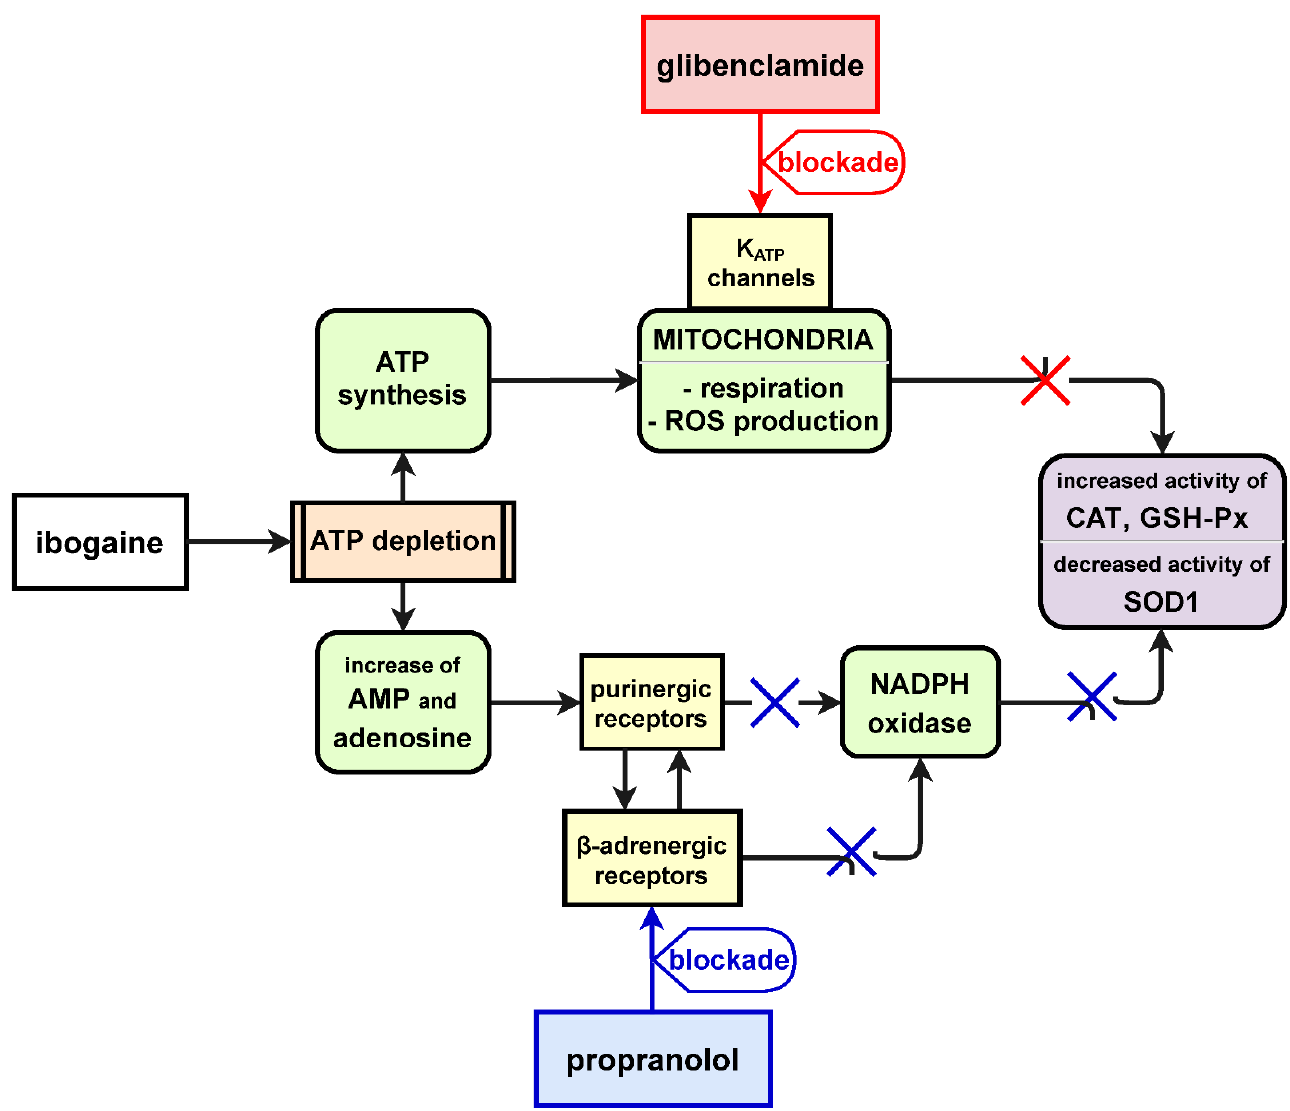
Figure 6. Schematic depiction of proposed role of β -adrenergic receptors and K ATP channels in ibogaine mediated pro- antioxidant action.